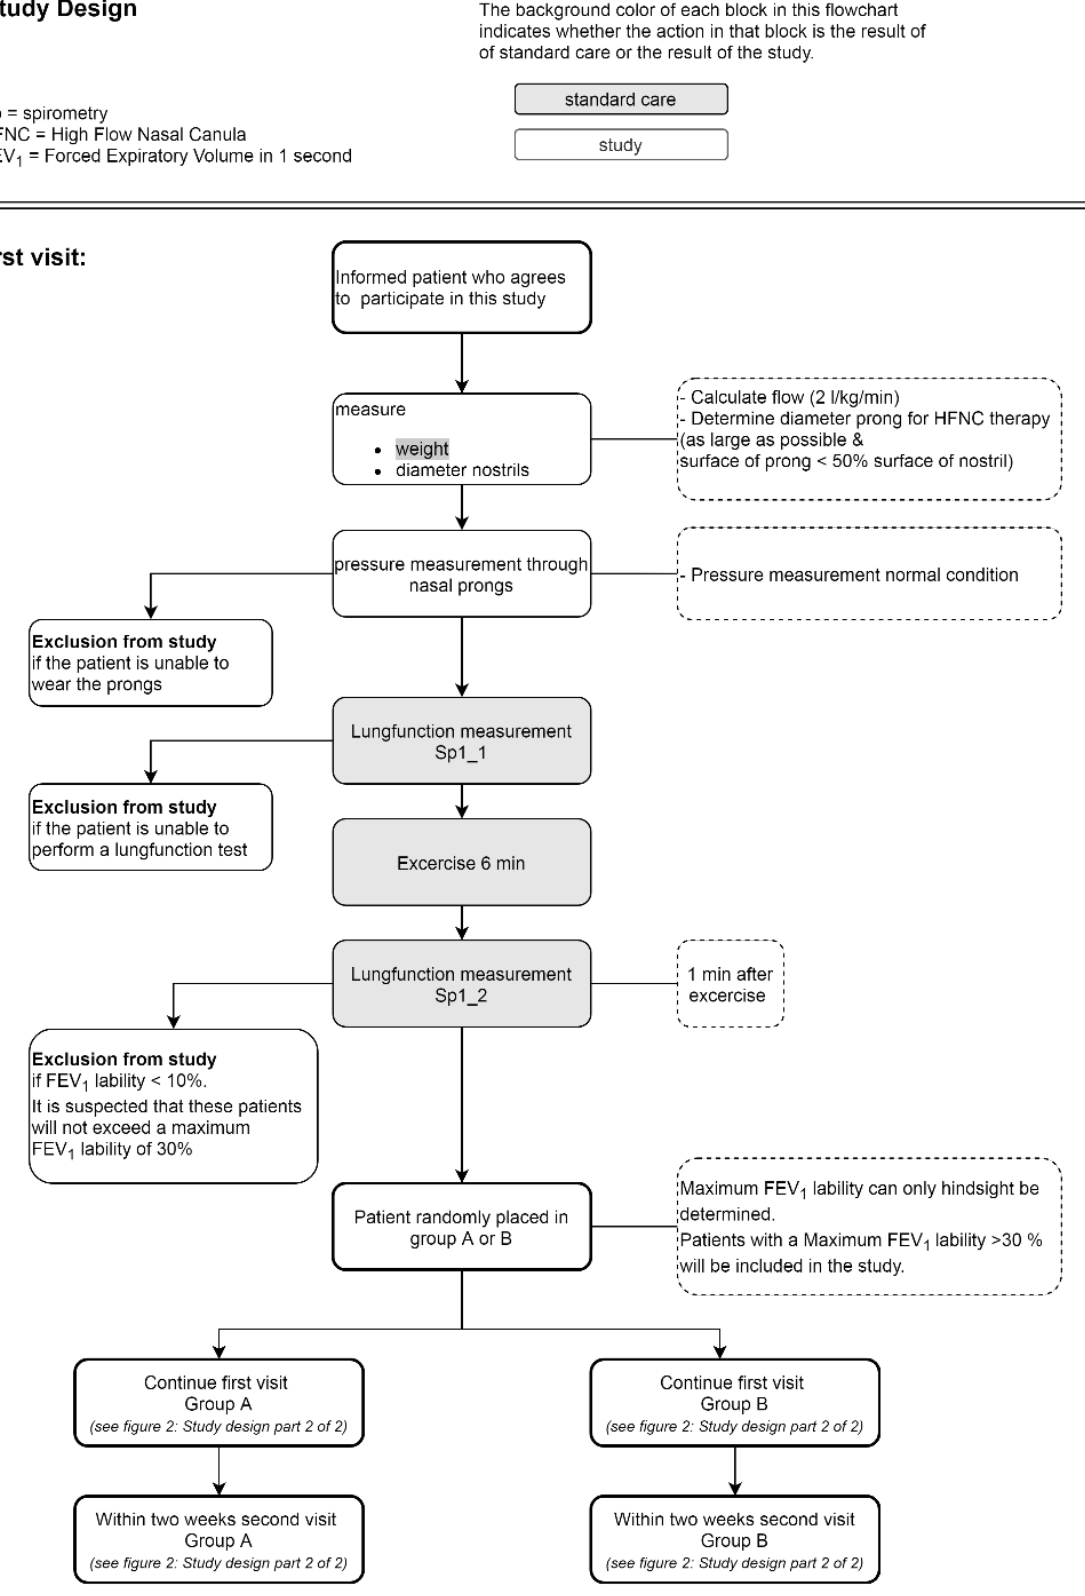
Figure 3. Study design (part 1 of 2). Figure 3.